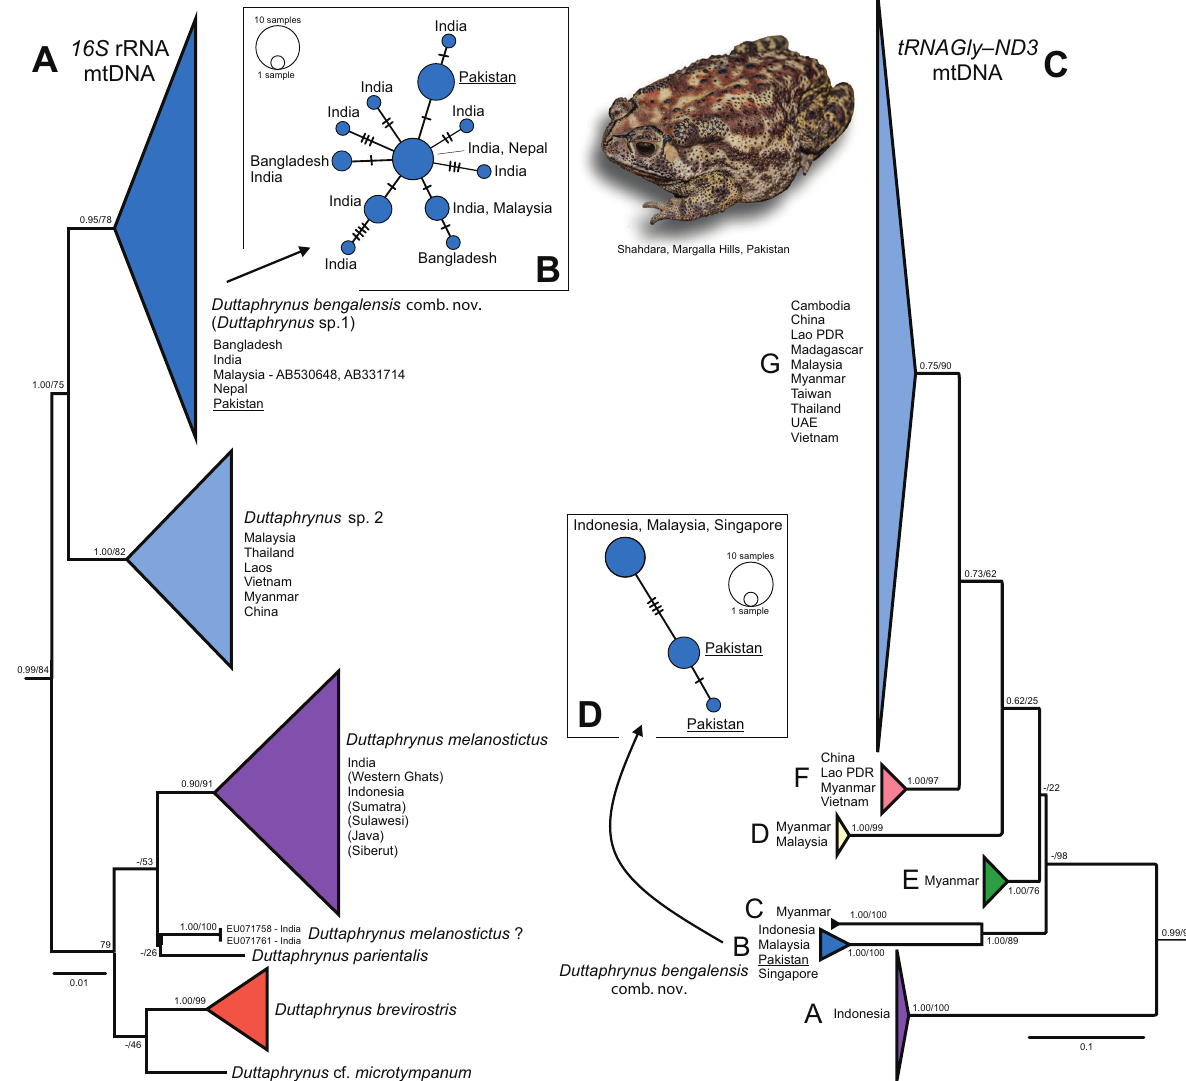
Figure 1. The molecular phylogenetic reconstruction of the Duttaphrynus melanostictus complex on 16S rRNA ( A ) sensu terminol- ogy of Bisht et al. (2021) and tRNAGly–ND3 ( C ) sensu Vences et al. (2017) together with median-joining networks ( B, D ) calculated from clades that include sequences of the “ hazarensis ” toads from Pakistan, now D . bengalensis comb. nov. (Daudin, 1802). The numbers on branches represent Bayesian Posterior Probabilities/bootstraps showing branch support. Sequence details are presented in Suppl. material 1: Table S1. The same colors of clades used for particular mtDNA trees reflect clade affiliation. The pictured individual represents a population from Shahdara, Margalla Hills, Islamabad,